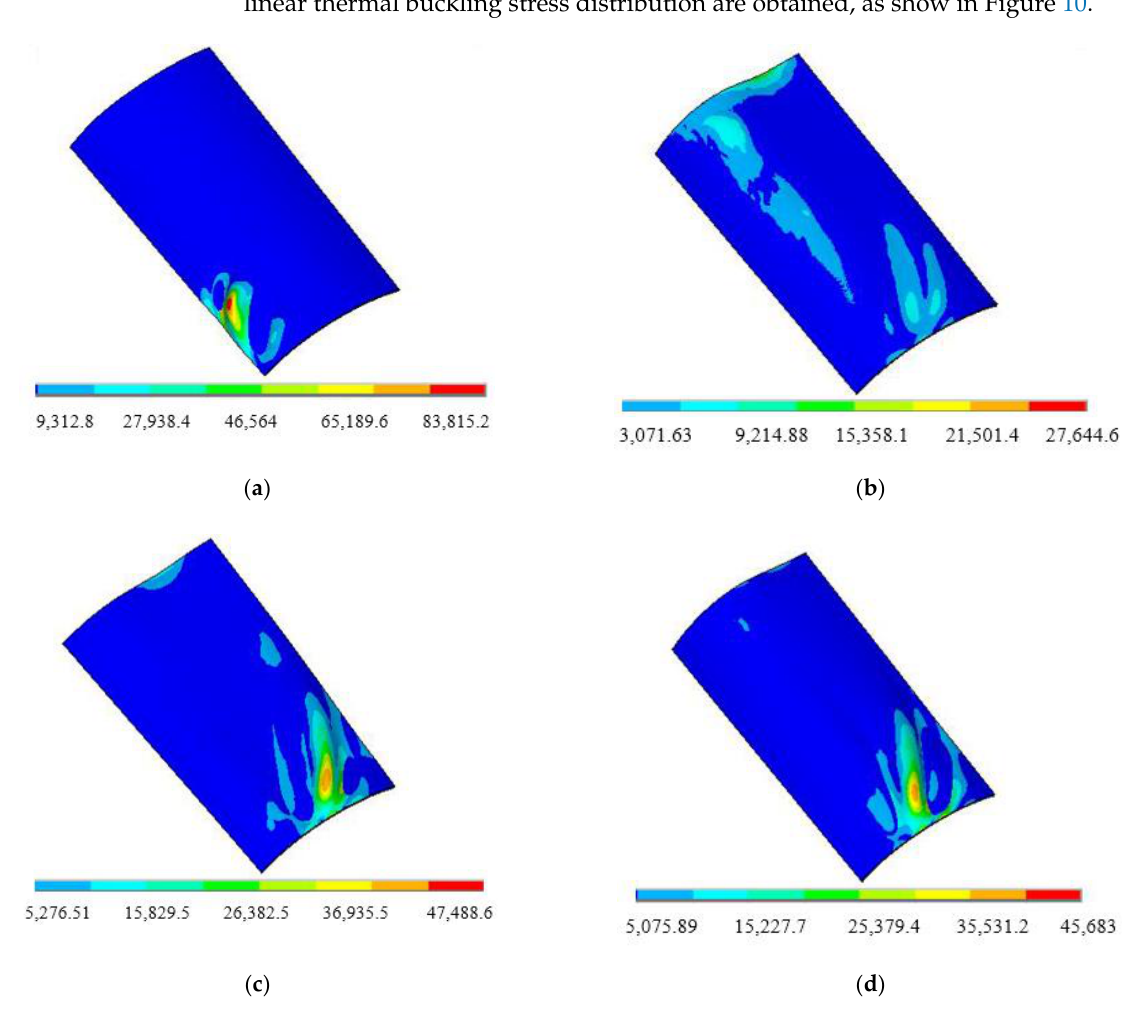
Figure 10. The linear buckling stress distribution of blades. ( a ) The first-order mode; ( b ) the second- order mode; ( c ) the third-order mode; and ( d ) the fourth-order mode.